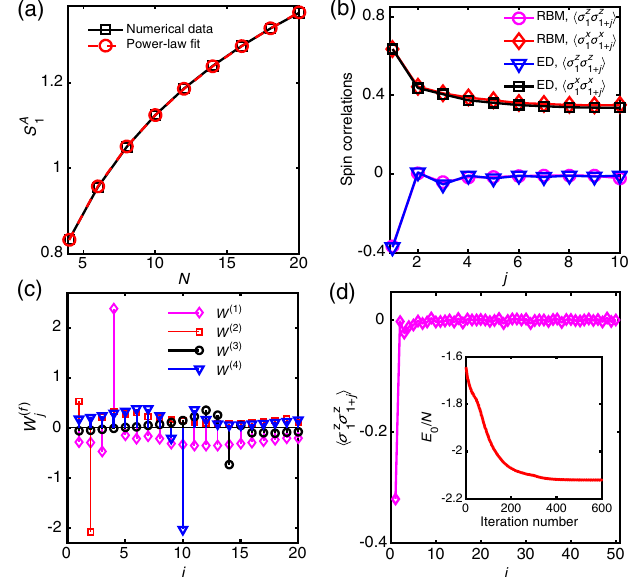
2 FIG. 7. Reinforcement learning of the ground state of the modified Haldane-Shastry model with power-law